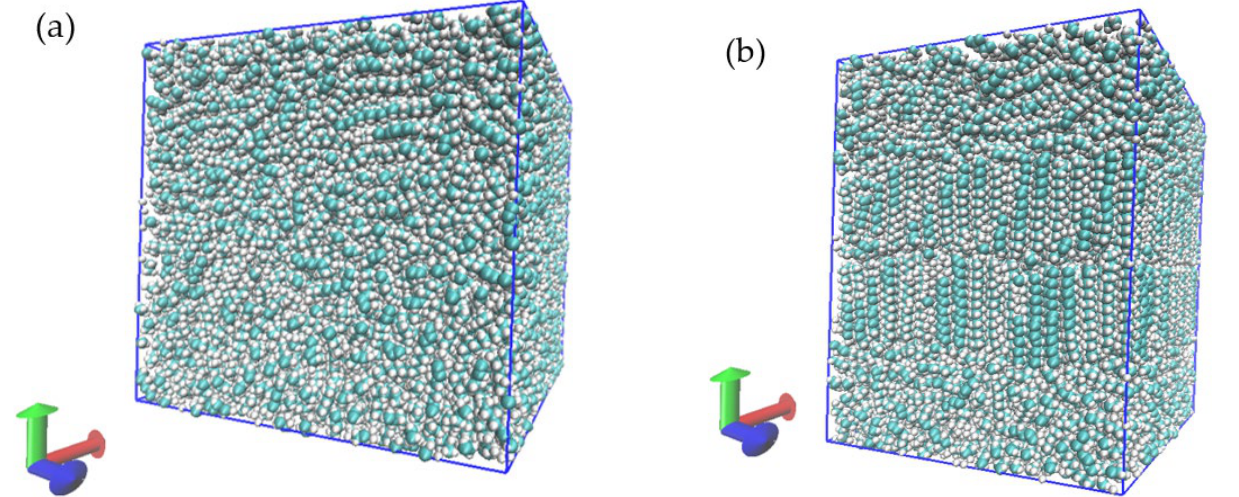
Figure 4. Snapshot of ( a ) one NA-free case and ( b ) case 1 at 7.2 ns at −3.15 °C.